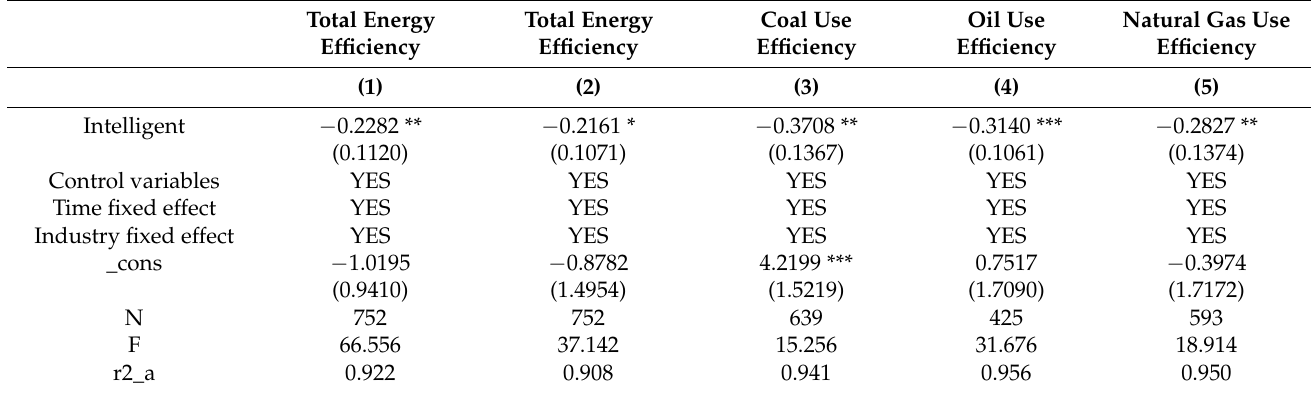
Table 13. The impact of intelligent manufacturing on energy